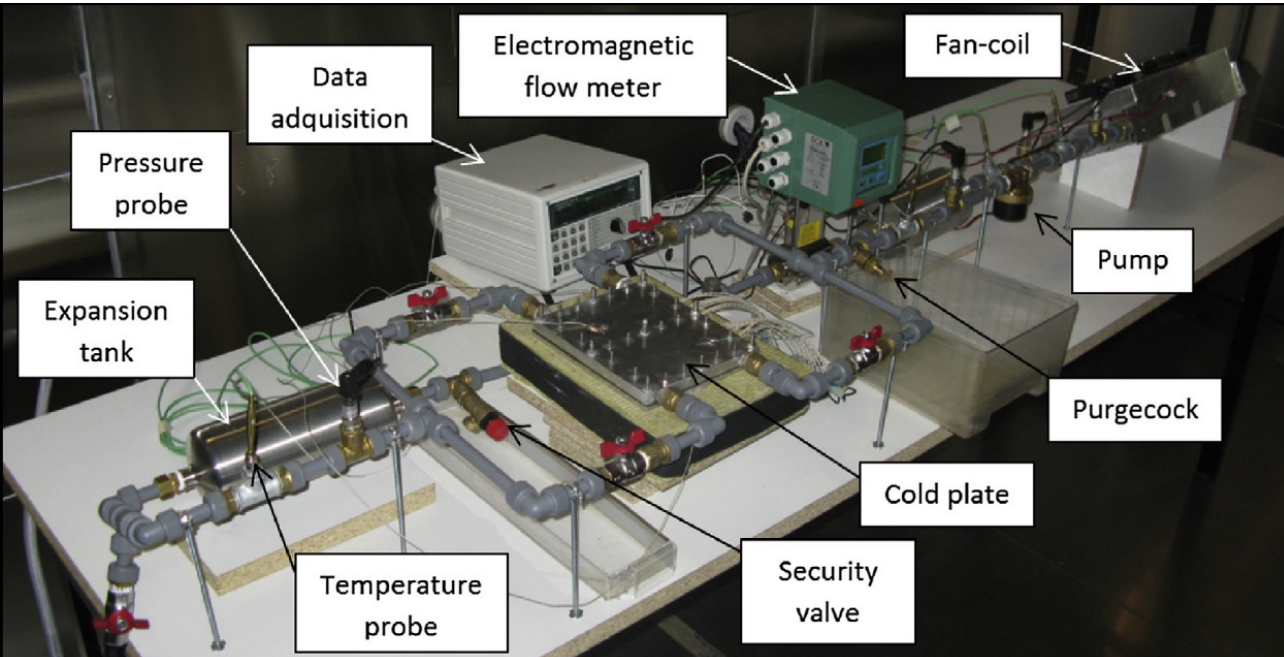
Figure 9. Experimental setup to investigate the consumption of the auxiliary equipment. Reprint with permission [64]; Copyright 2021, Elsevier.